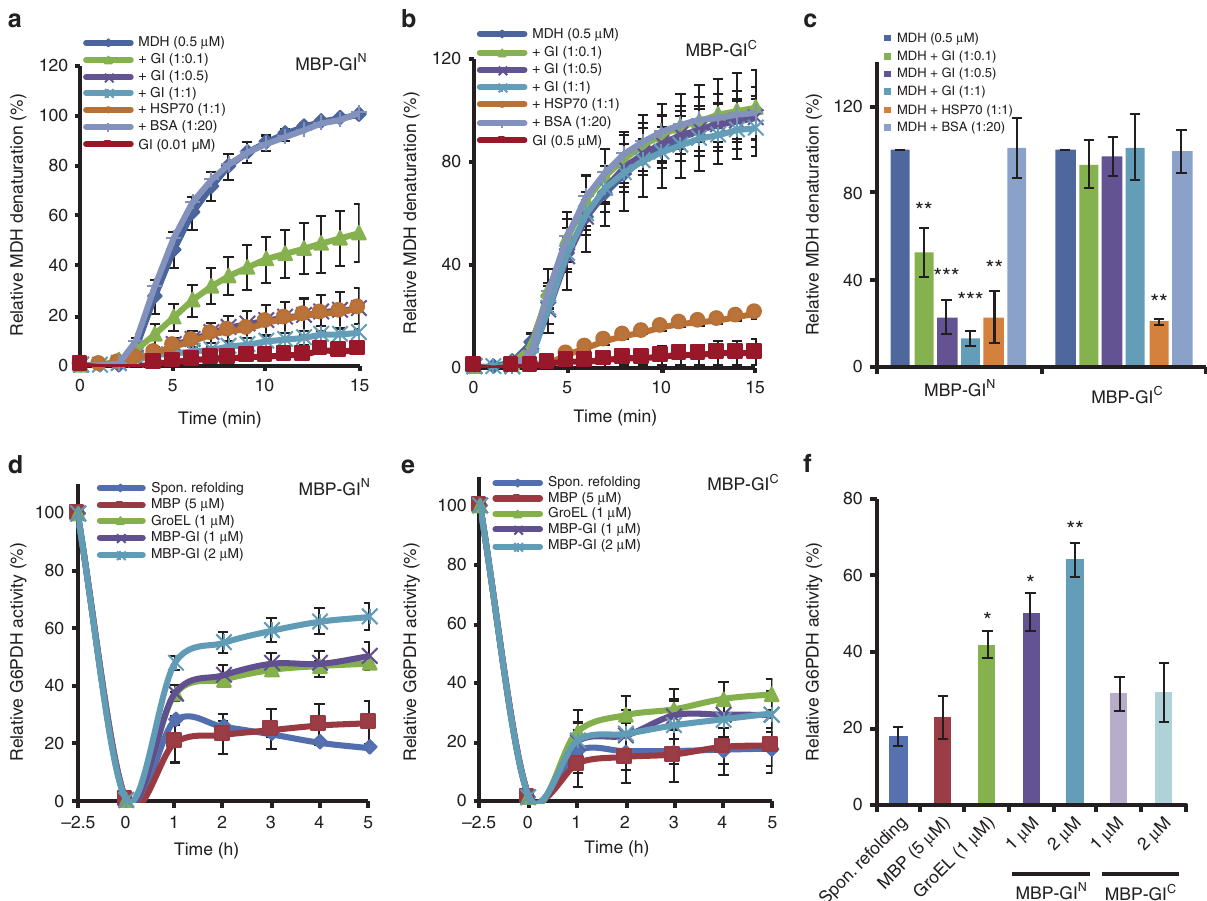
Fig. 1 GI N exhibits general molecular chaperone activity in vitro. a MBP-GI N decreases heat-mediated MDH aggregation with increasing stoichiometric parity. b MBP-GI C has no effect on heat-mediated MDH aggregation. Both GI polypeptides were tested using MDH (0.5 μ M) as a model substrate under thermal denaturing conditions (45 °C) in various molar ratios. HSP70 and BSA used as positive and negative controls, respectively. c The mean MDH denaturation state at the treatment endpoint of a and b relative to thermal-denaturation of MDH alone. The holdase assay ( a – c ) measures the aggregation of the model substrate MDH (0.5 μ M), by measuring the turbidity (light scattering) at 340 nm under thermal denaturing conditions for 15 min at 45 °C. The turbidity of MDH alone at 15 min was set to 100%, and that from each treatment expressed relative to it. d MBP-GI N refolds chemically denatured G6PDH. e MBP-GI C cannot refold chemically denatured G6PDH. f The mean G6PDH activity at the treatment endpoint of d and e relative to the activity of undenatured G6PDH. The foldase assay determines G6PDH activity by measuring absorbance at 340 nm (Abs 340 ) from NADPH formation. G6PDH was denatured in 4 M guanidine-HCl for 2.5 h ( − 2.5 h), and the relative G6PDH activity (compared to native G6PDH activity, set to 100%) was monitored in the absence (Spon. Refolding, spontaneous refolding) or presence of MBP, GroEL, and MBP-GI N or MBP-GI C for 5 h in renaturation buffer. GroEL and MBP were used as a positive and negative control, respectively. * P < 0.05; ** P < 0.01; *** P < 0.001; two-tailed Student ’ s t -test. Data are means ± s.e. ( n =